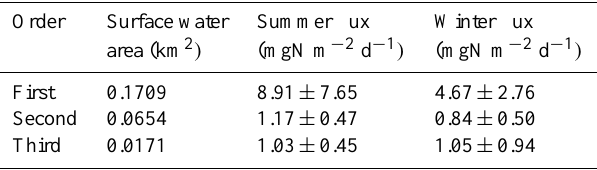
Table 1. Nitrous oxide fluxes at the water–air interface for the sum- mer and the winter period for different stream orders of the Orgeval